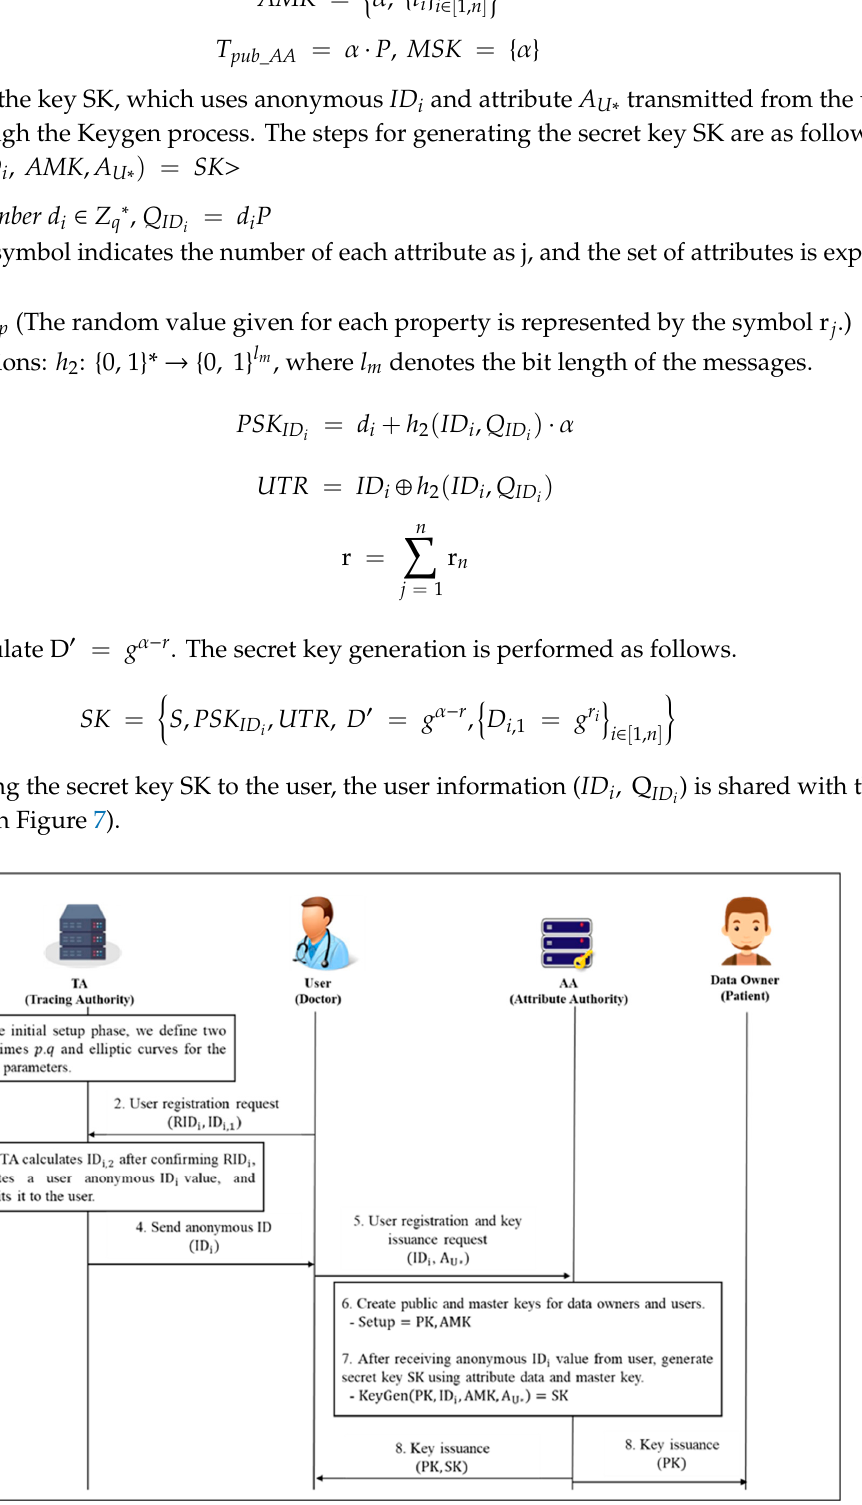
Figure 7. User Registration and Key Issuance Phase.